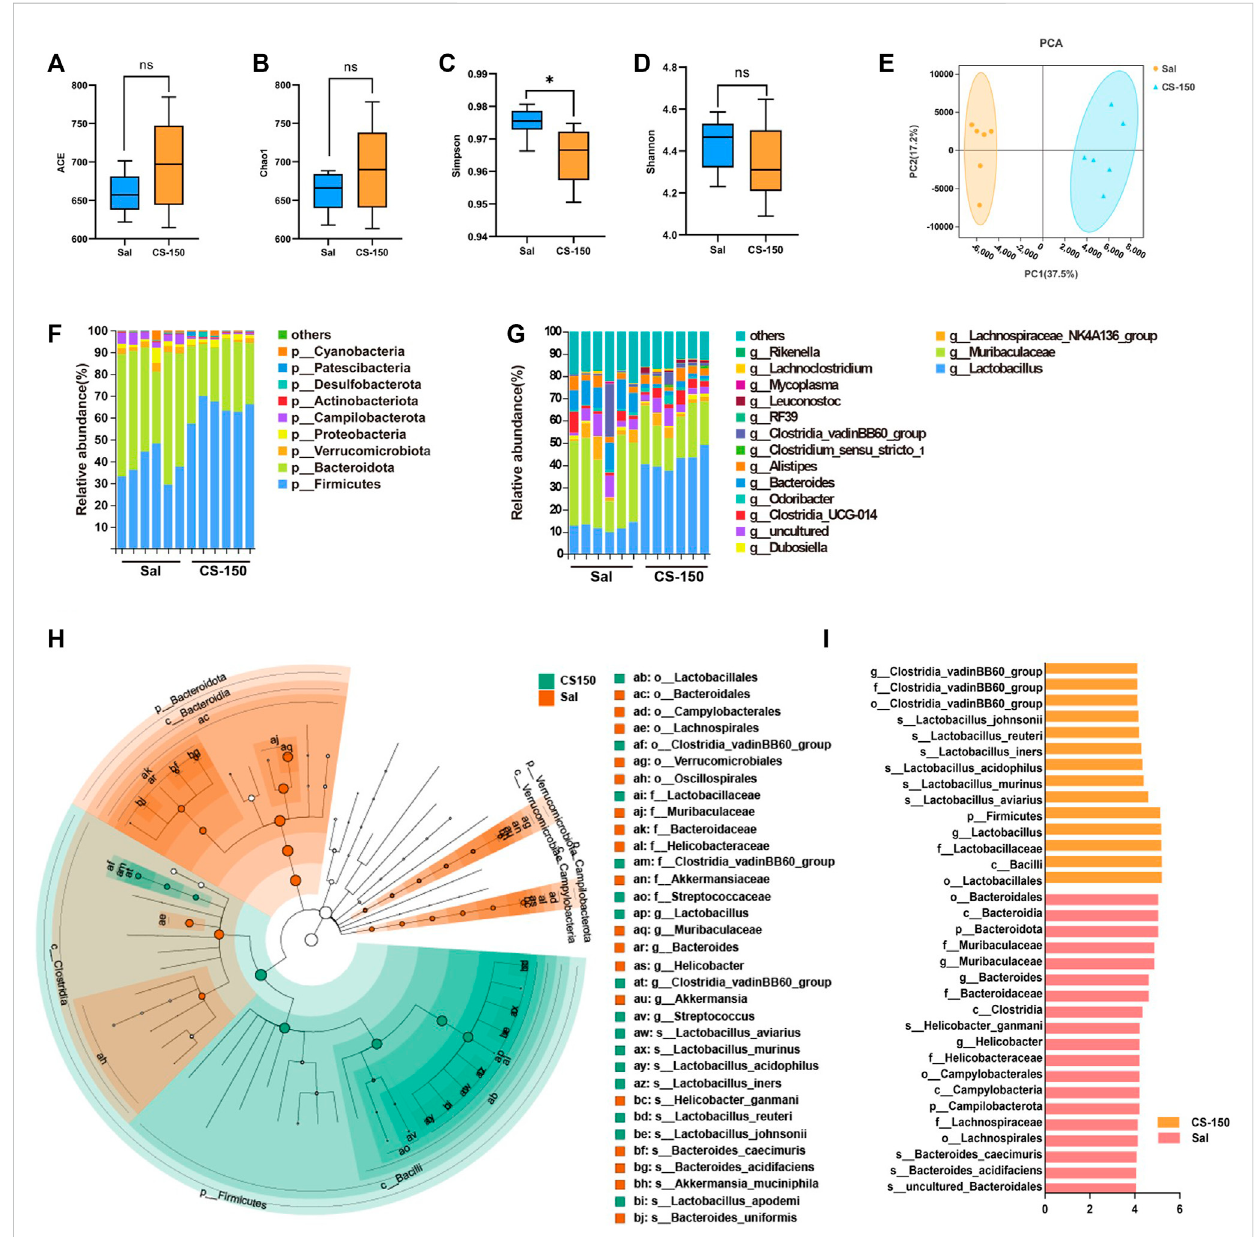
FIGURE 4 CS altered gut microbiota structure in CUS-exposed mice. (A – D) The ACE, Chao1, Simpson, and Shannon index values of the Sal group and CS-150 group. (E) PCA based on the Bray-Curtis distance for the gut microbiota. (F) Microbial distribution at the phylum level. (G) Microbial distribution at the genus level. (H, I) Cladogram and histogram of LDA scores greater than four based on LEfSe. Data are expressed as the mean ± standard error. p < 0.05 indicates a statistically signi fi cant